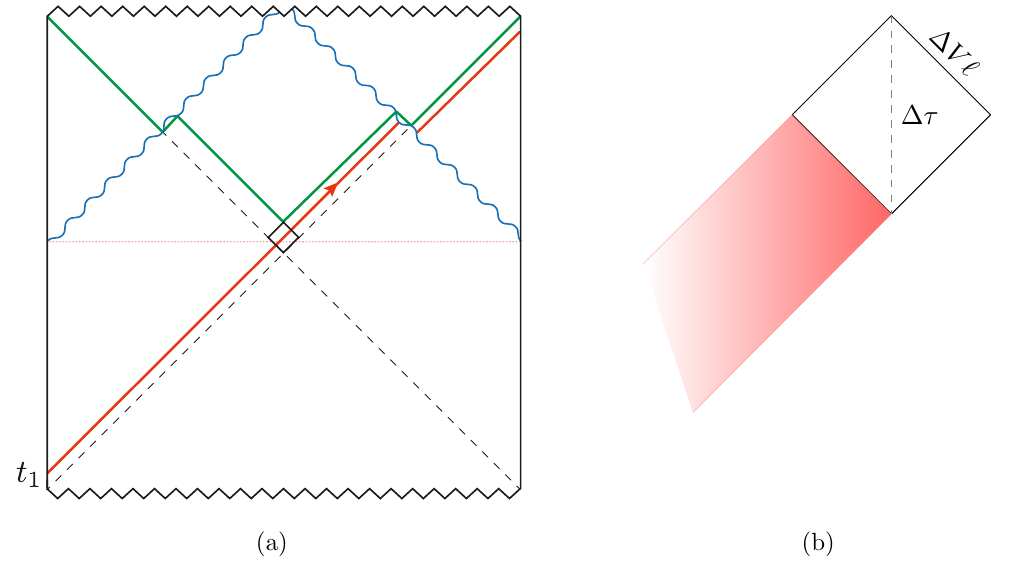
Figure 4. (a) The blue wavy lines represent the negative energy. The green line shows how the future horizon recedes due to the backreaction of the negative energy on the geometry. As the future horizon moves up, a diamond region is revealed in the middle of the diagram. The past horizon remains una(cid:11)ected. The red line is the positive energy signal that we send through the wormhole. (b) Here, we have zoomed into the diamond region. The side of the diamond is equal to (cid:1) V ‘ . (cid:1) (cid:28) is the amount of proper time that the wormhole remains open. The red region represents a signal that passes through the wormhole